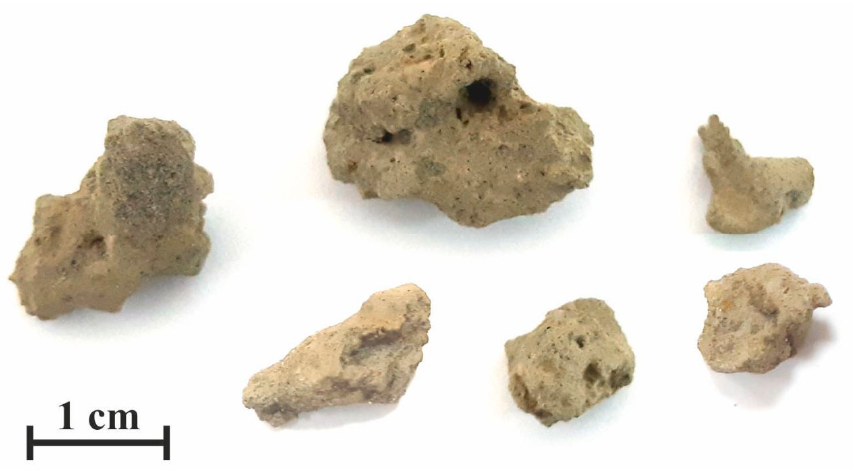
Figure 3. Photographs of representative cold-seep carbonate nodules collected in the northern part of the Laptev Sea.